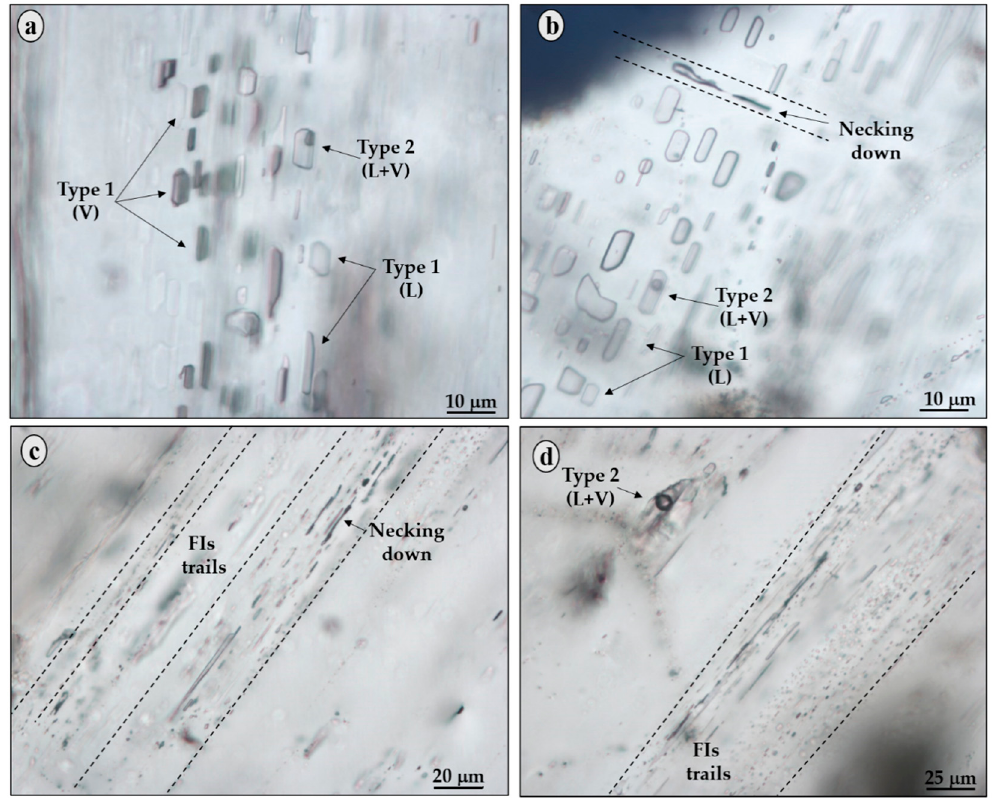
Figure 4. Type 1 and Type 2 fluid inclusions observed in crystals from gypsrudites facies ( a , b ) with evidence of necking down process ( b ); crystal from the branching-like facies ( c , d ) displaying trail of FIs, necking down ( c ) and a large (~50 µ m in size) irregular inclusion ( d